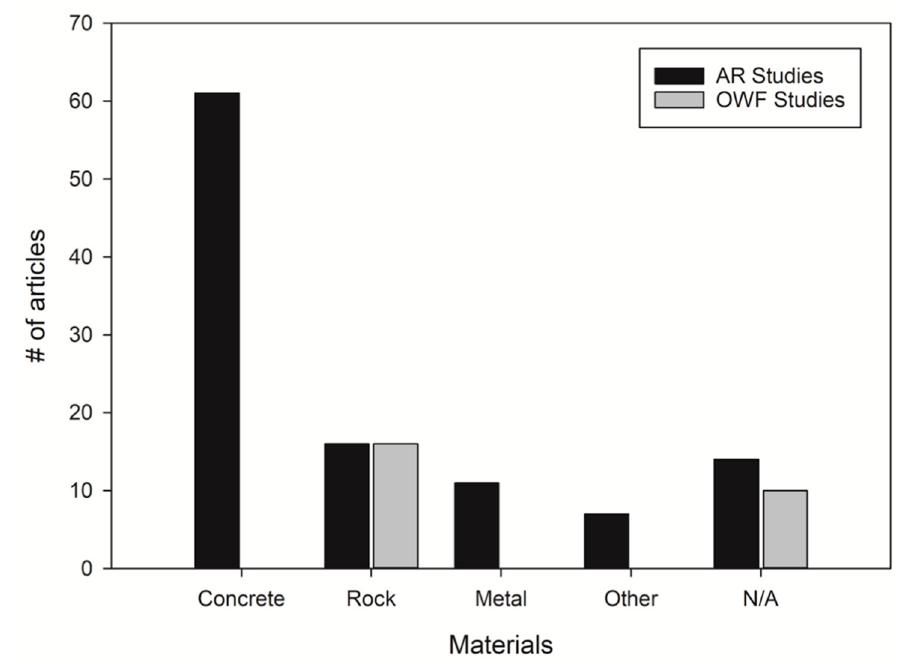
Figure 5. Materials used for artificial reefs (ARs) and scour protection associated with o ff shore wind farms (OWFs). Some papers are included in multiple categories, because they studied more than one material. “Other” includes scrap materials, wood, tires and PVC materials. “N / A” means that the material used was not specified in the